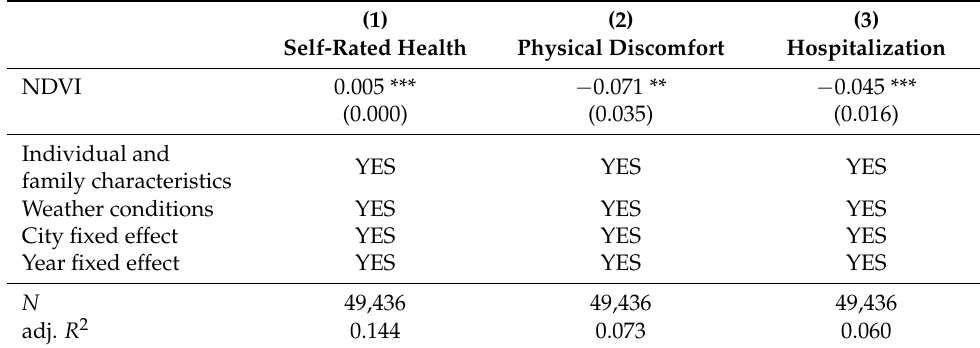
Table 7. Employing the ordinary least square